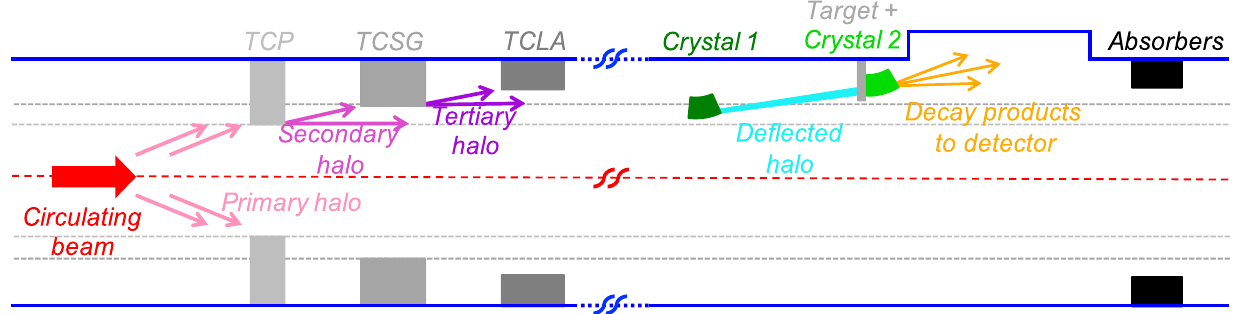
Fig. 1 Workingprincipleofthedouble-crystalschemeforfixed-targetexperimentsanddipolemomentmeasurementsattheLHC,anditsintegration in the collimation